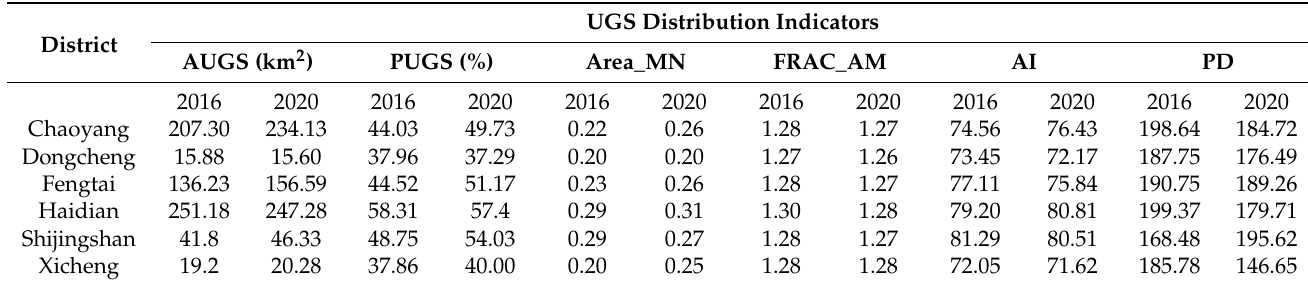
Table 6. Descriptive statistics of urban green space distribution indicators for six districts in 2016 and 2020. UGS Distribution Indicators District